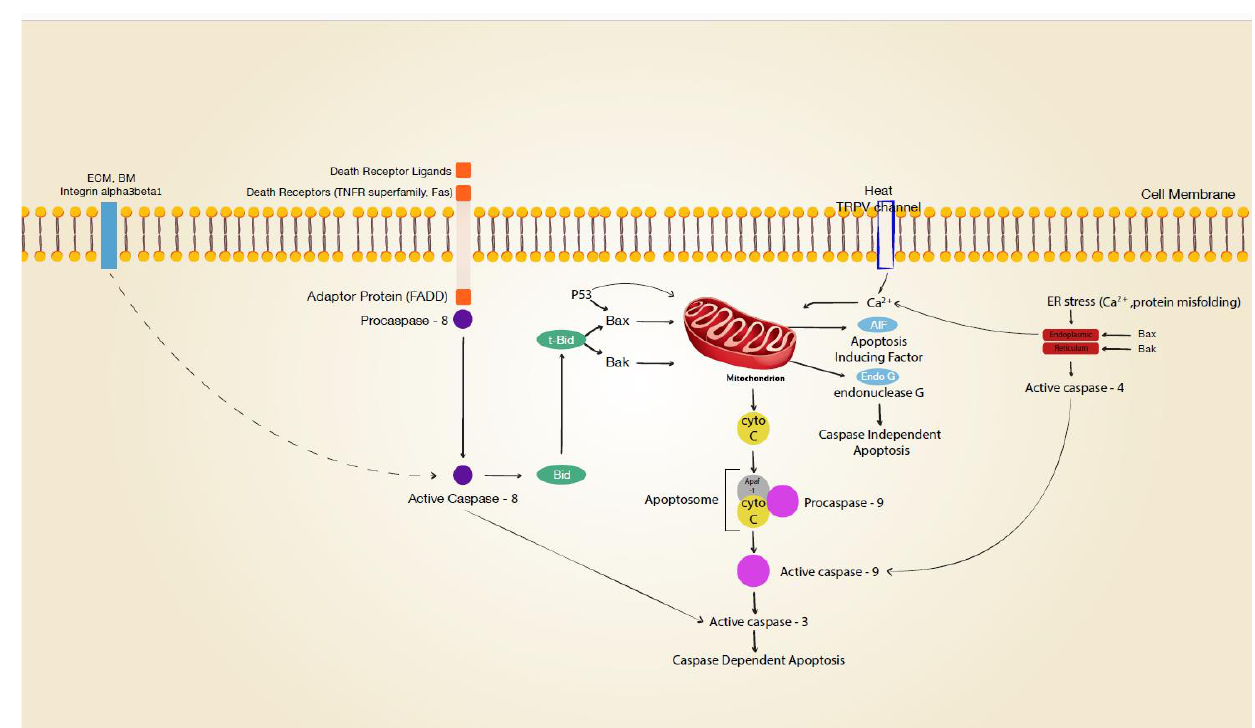
Figure 2. Signal transduction leading to apoptosis. Various cellular stress, e.g., matrix disruption, death receptor activation, transient vanilloid receptor (TRPV) opening, protein misfolding may initiate apoptotic pathways in keratinocytes. ECM extracellular matrix; BM basement membrane; dotted line indicating activation after integrin internalisation.